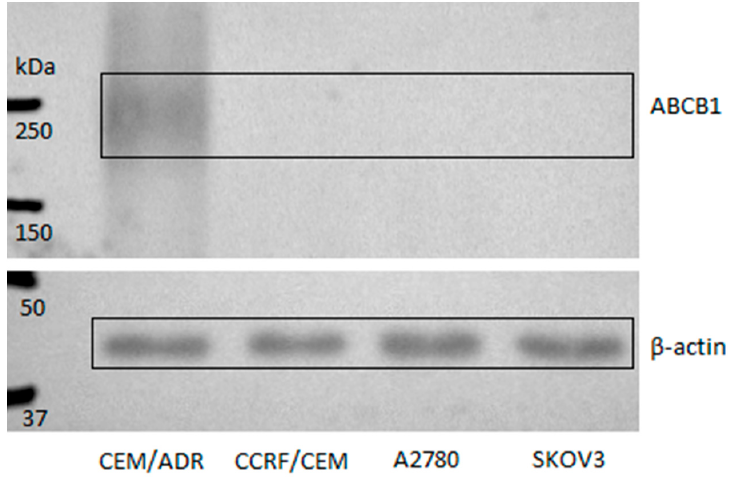
Figure 4. Immuno-quantification of ABCB1 level in the tested cancer cell lines. Protein β -actin was used as a reference housekeeping one.